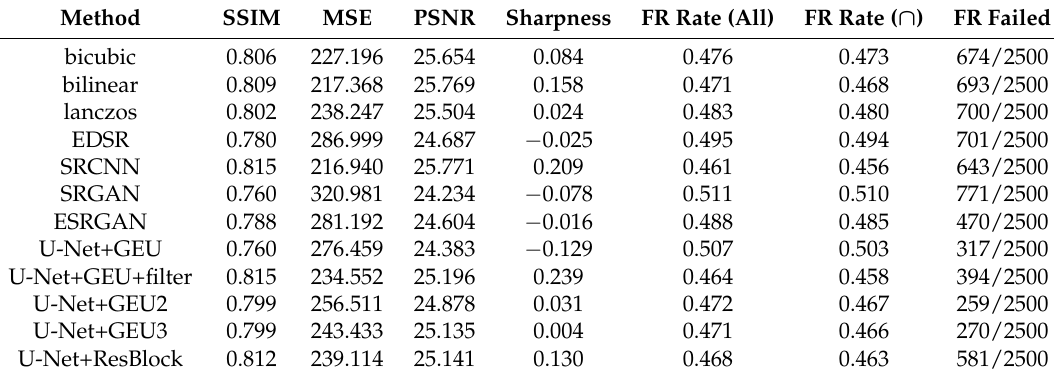
Table 2. Single-frame and multi-frame methods performance